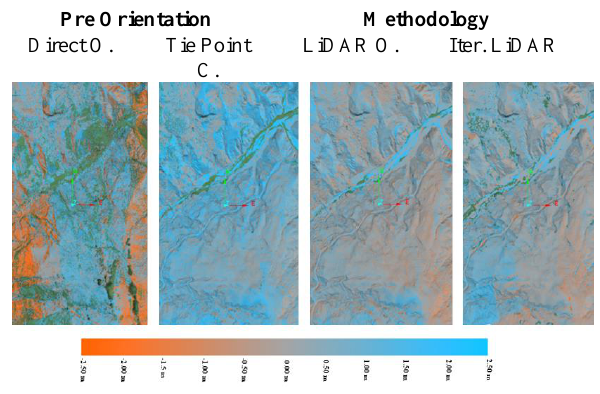
Figure 8: 2008 Orientation Evolution